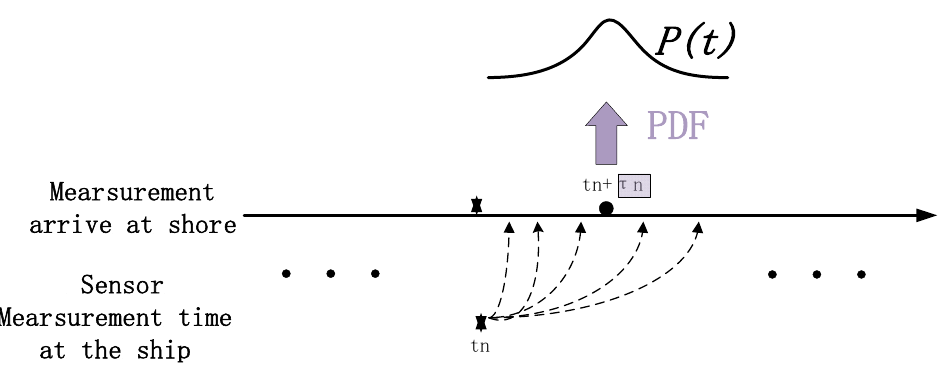
Figure 2. The ship–shore sensor measurement with communication delay.